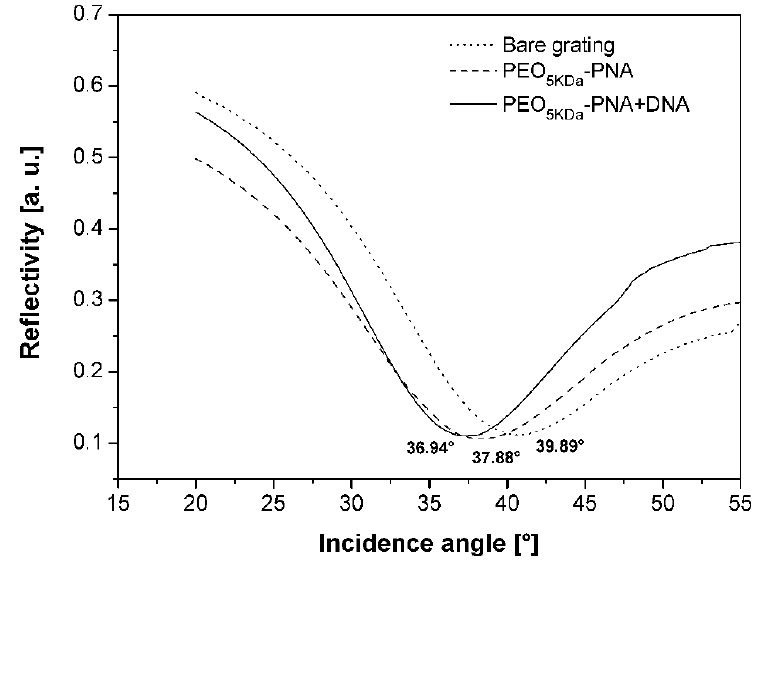
Figure 6. Reflectivity curves obtained on the bare grating as such, after PNA-PEO grafting and complementary DNA